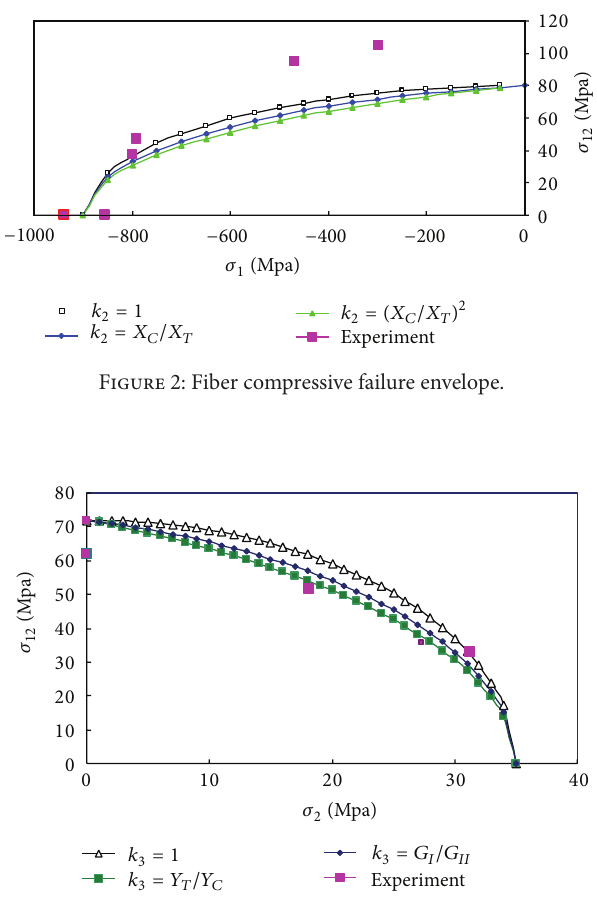
Figure 3: Matrix tensile failure